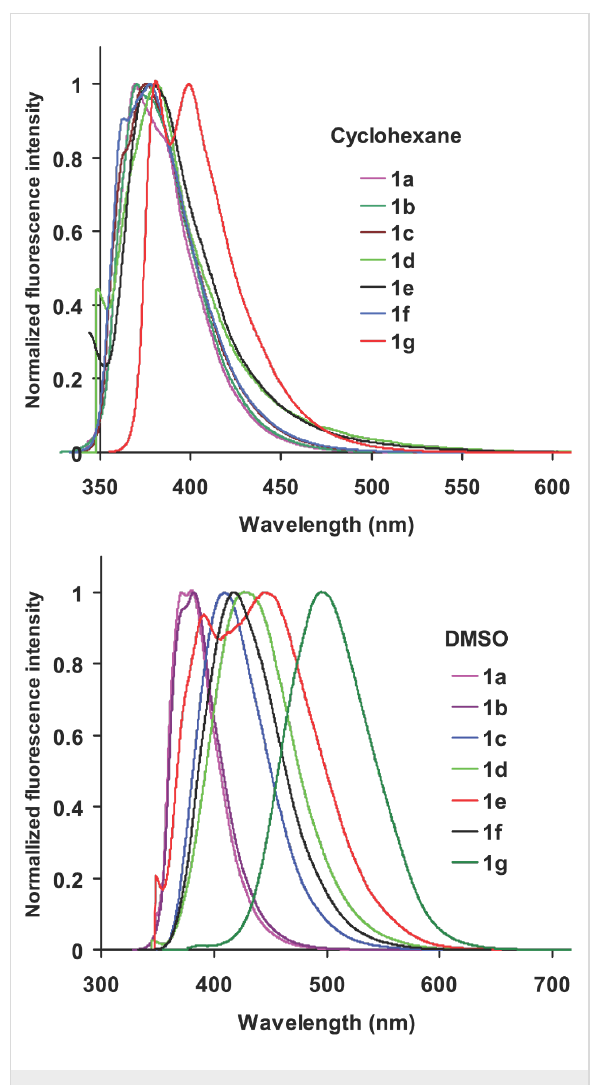
Figure 2: Fluorescence emission spectra of 1a – g in cyclohexane and DMSO (10 − 5 M), λ ex = 335